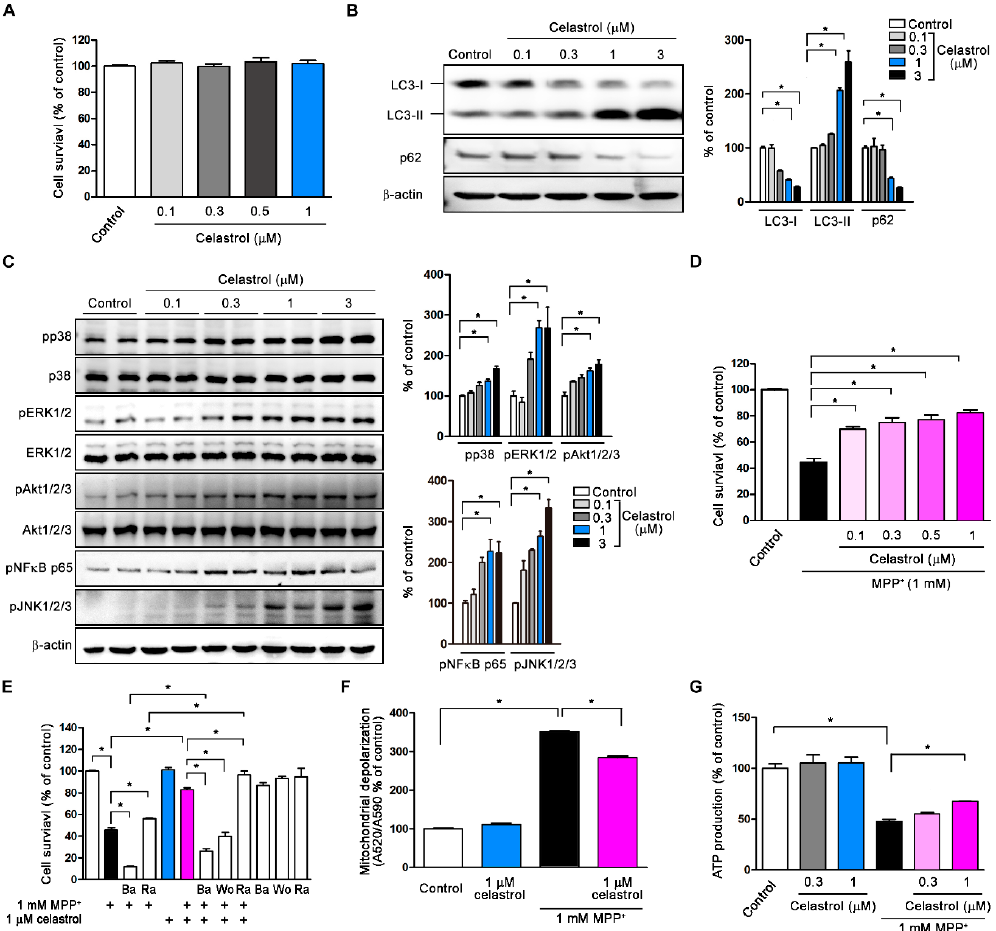
Figure 2. Celastrol activates autophagy and inhibits MPP + -induced neurotoxicity in dopaminergic neurons. The dopaminergic cell line SH-SY5Y was treated with celastrol (0.1–3 µ M) for 2 to 24 h. ( A ) MTT assay results show that celastrol did not affect cell viability in 24 h. ( B ) Western blot data show that celastrol treatment for 4 h dose-dependently increased autophagosome formation (LC3-I ↓ and LC3-II ↑ ) and enhanced autophagic flux/substrate degradation (p62 ↓ ) as compared to control. ( C ) Celastrol dose-dependently enhanced p38, ERK1/2, Akt1/2/3, NF κ Bp65, and JNK1/2/3